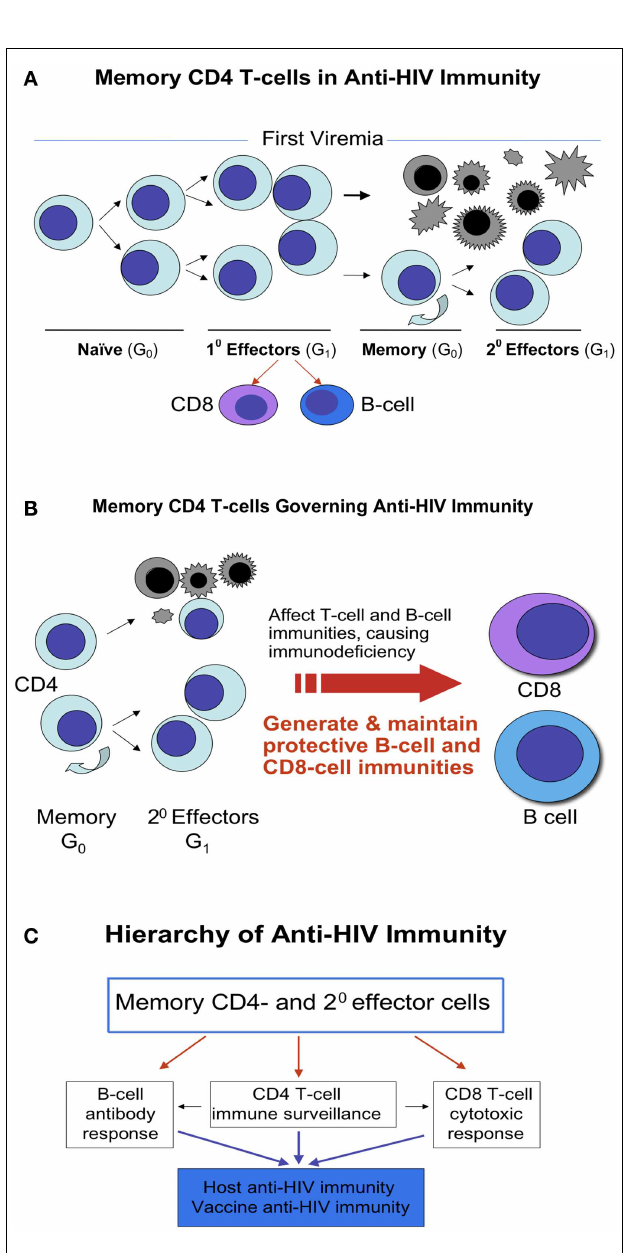
FIGURE 1 | Memory CD4T-cells in anti-HIV immunity . (A) Naïve CD4 T-cells are derived from CD4 lineage progenitors. Upon meeting a pathogen, such as HIV, naïve CD4T-cells differentiate into antigen specific effector cells. Some of them die due to the viral infection or their biological destinies, whereas some of them survive and become memory cells and further develop into secondary effector cells.These memory cells retain the stem cell properties of asymmetric division, self-renewal, and differentiation into effector cells. (B) When encountering HIV again, these antigen specific memoryT-cells, in this case HIV specific, repeat the process in (A) , and majority of effector cells die but some of memory cells sustain to continue the cycle. In general, the earlier the application of HAART is, the more memory cells preserve or survive. (C) The memory CD4T-cells act as a commander in chief, in the leadership position for launching anti-HIV immunity as these cells govern functions of both CD8-cells and B-cells, regulate both cellular and humoral immunities, by which determine the prognosis of